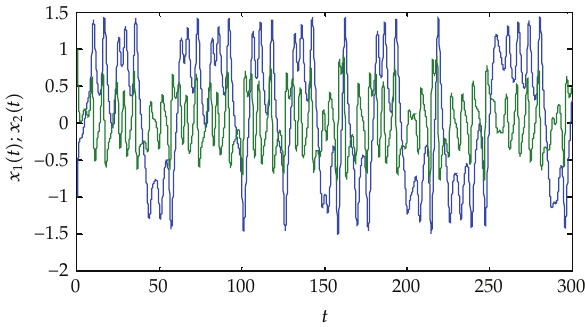
Figure 1: Typical state trajectories of the uncertain Du ffi ng-Holmes system for (cid:2) 3.1 (cid:3) .